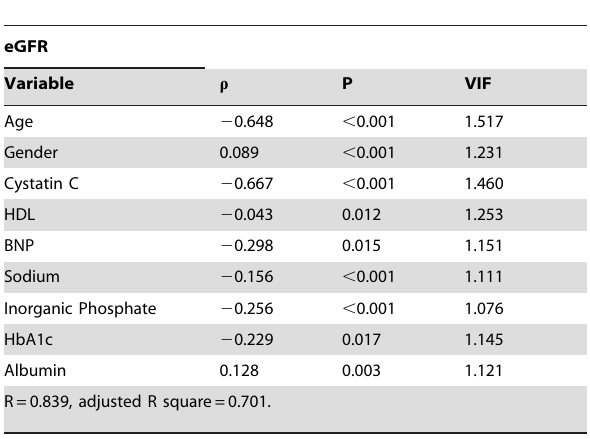
Table 4. Spearman correlation coefficients ( r ) between eGFR/ACR and the significantly correlated variables.